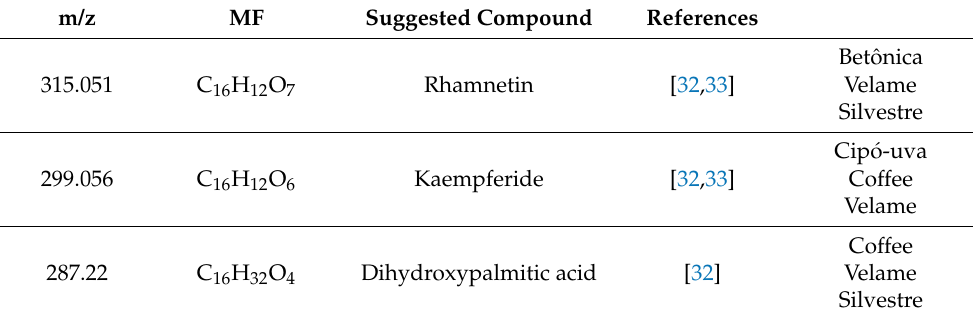
Table 6. Comparison with literature formulae for